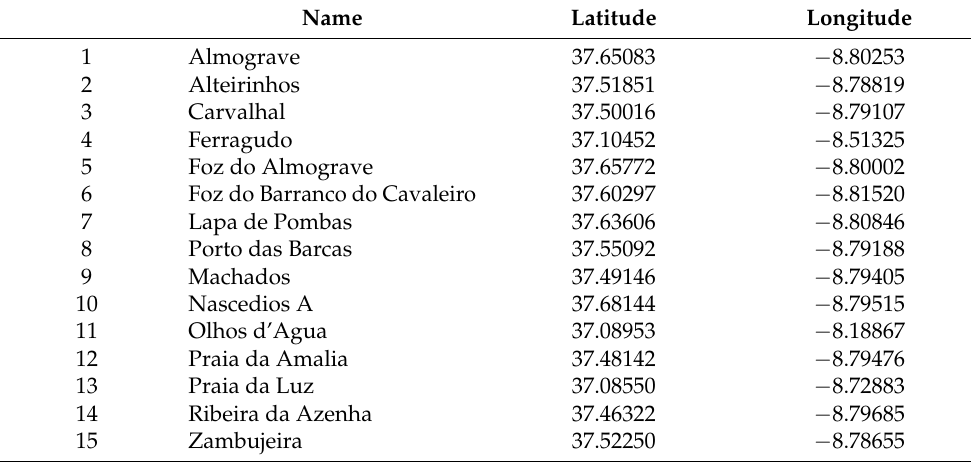
Table 4. Location of coastal springs identified in situ during the fieldwork reconnaissance campaign in the South and Southwest coast of Portugal.